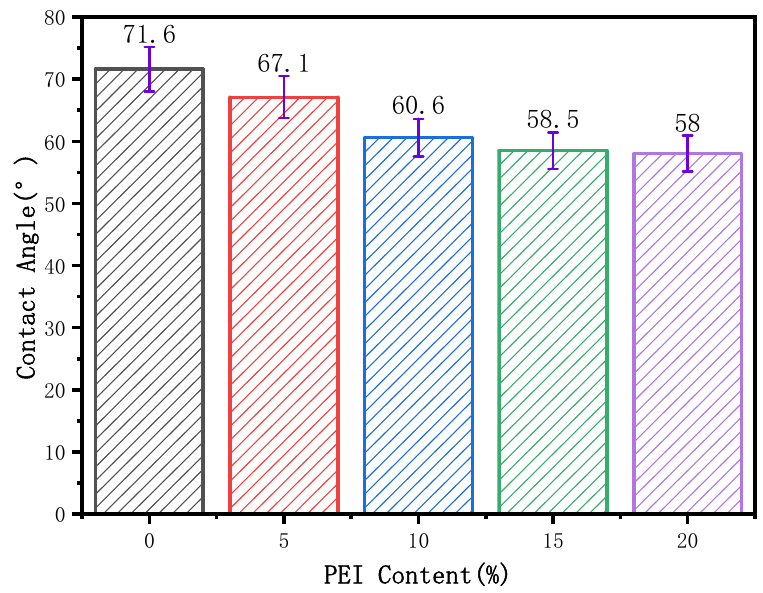
Figure 7. Effect of PEI content on contact angle of blended membrane.